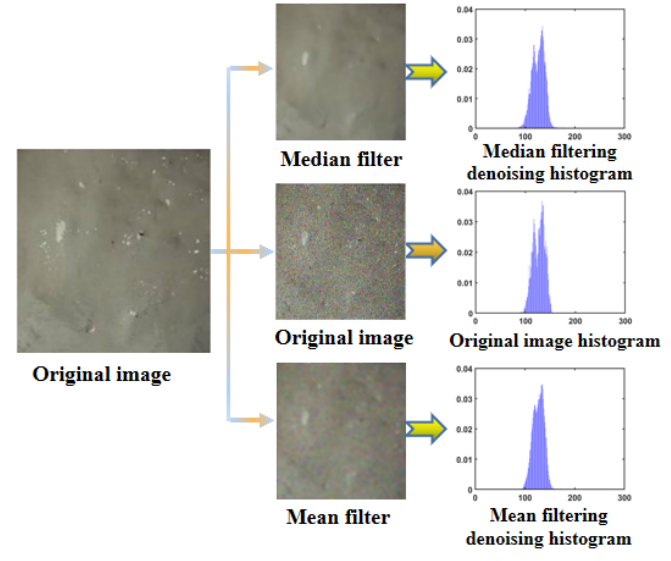
Figure 6. Filtering denoising for image of slurry.